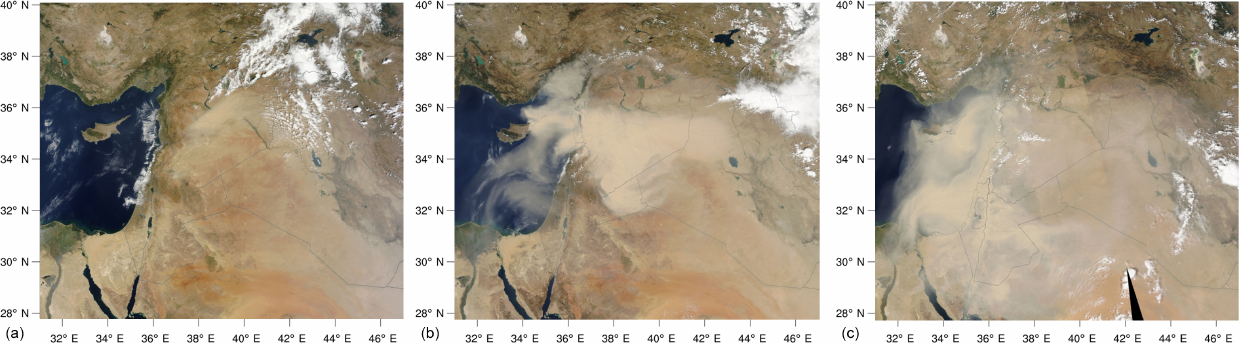
Figure 1. MODIS VIS satellite images of the EM region, at (a) 08:15UTC, 6 September, (b) 10:35UTC, 7 September, and (c) 11:18UTC, 8 September 2015 (NASA Worldview,